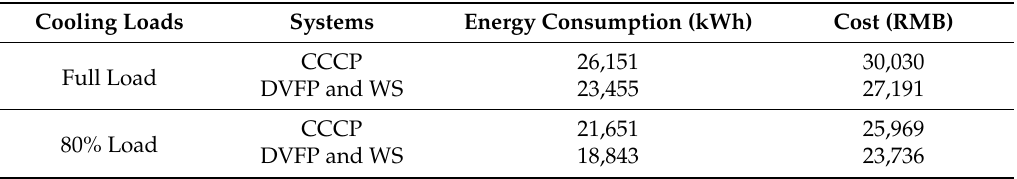
Table 3. Comparison of systems on typical days with different cooling